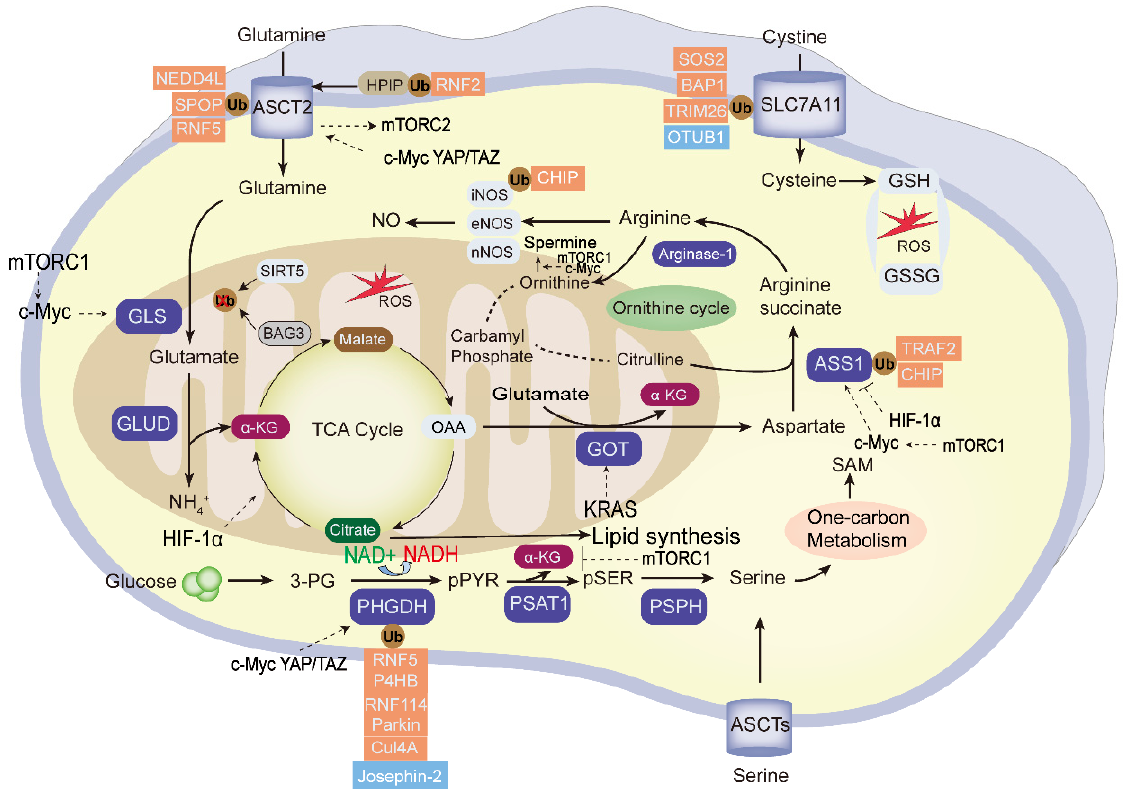
Figure 3. The ubiquitination and deubiquitination of the essential enzymes in tumor amino acid metabolism. “Glutamine addition” in tumor cells provides carbon and nitrogen to replenish the tricarboxylic acid cycle (TCA) and maintain mitochondrial ATP production. The essential enzymes of amino acid metabolism reprogramming are highlighted in blue. The ubiquitin enzymes (red) and DUBs (blue) negatively or positively regulate the activity of the key enzymes; among them, PHGDH, ASCT2, SLC7A11, and ASS1 were the frequently UPS-modified enzymes, and the glycolysis intermediate 3-PG can be used to the synthesis of serine. Transcription factors mTOR, KRAS, HIF, c-Myc, and YAP/TAZ regulate the tumor amino acid metabolism. GLS, glutaminase; GLUD, glutamate dehydrogenase; α -KG: α -ketoglutarate; 3-PG, 3-phosphoglycerate; OAA, oxaloacetate; GOT2; Glutamic-oxaloacetic transaminase 2; PHGDH,3-phosphoglycerate dehydrogenase; PSPH, phosphoserine phosphatase; ASS1, argininosuccinate synthase1; GSH, glutathione; GSSG,